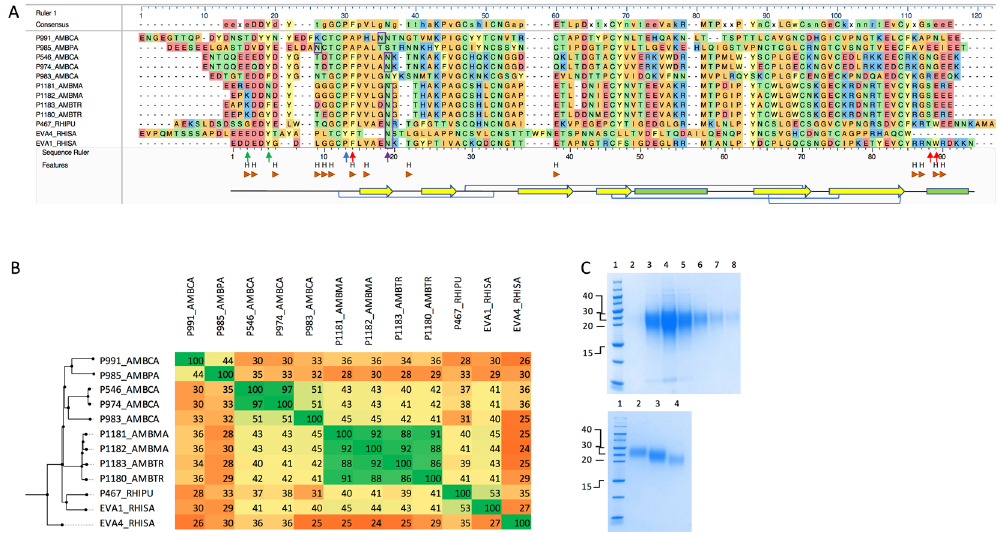
Figure 3. Analysis of CC-chemokine binding evasin sequences. ( A ) CLUSTAL-W alignment of CC-chemokine binding evasins with evasins 1 and 4 (EVA1, EVA4). Peptide sequence prefix indicates the identity, and suffix indicate the tick species as follows: RHISA and RHIPU – Rhipicephalus sanguineus and pulchellus respectively, and AMBPA, AMBCA, AMBMA, AMBTR - Amblyomma parvum, cajennense, maculatum, triste ) respectively. Amino acid residues are color coded by physicochemical properties, and consensus sequence presented above the alignment. Evasin 1 H-bonds to CCL3 are shown as “H”. Evasin 1 structural motifs are indicated as yellow arrows (beta-sheet), green bars (alpha-helix), and blue connectors (disulfide bonds), and were taken from the analysis of the evasin 1:CCL3 structure 3FPU provided in PDBSum 18 . The blue arrow indicates the P13 residue in evasin 1 that targets the disulfide bond in CCL3 13 . Red arrows indicate F14, N88 and W89 residues in evasin 1 that make contact with CCL3. Green arrows indicate E16 and Y19 residues of evasin 4. The purple arrow indicates N19 in evasin 1, which is glycosylated. The conserved glycosylation sites at the N-terminus predicted using NetNGlyc are boxed in purple. ( B ) Sequence conservation between CC-chemokine binding evasins and EVA1 and EVA4 peptides. Percent identities between sequences are shown and were calculated by performing BLASTP with default parameters, and are color coded with green indicating high sequence conservation, yellow indicating medium, and orange indicating low conservation. CC-chemokine binding evasins are arranged according to the sequence-similarity based phylogenetic tree shown on the left of the figure. ( C ) Expression and purification of P991_AMBCA. Colloidal Coomassie stained gels of proteins fractionated by SDS-PAGE. Top panel: Elutions from nickel affinity column, lanes 3–8. Molecular weight ladder (kDa) lane 1. His-tagged P991_ AMBCA has a predicted MW including tag of 15.7 kDa. Bottom panel: Fractions collected from size exclusion column chromatography of the pooled material obtained from the nickel affinity